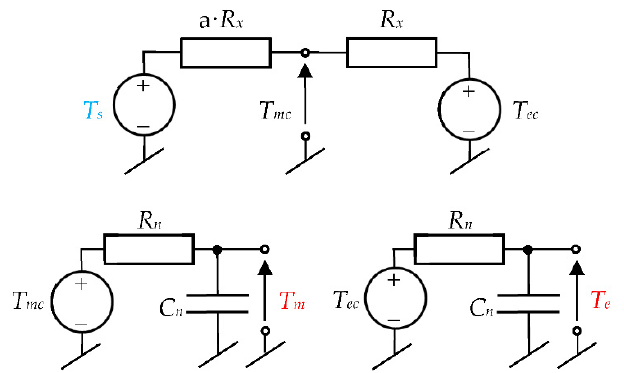
Figure 10. Combined thermal models of the sensors and clothing—initial approach. The input quantities are given in red, and the output in blue.